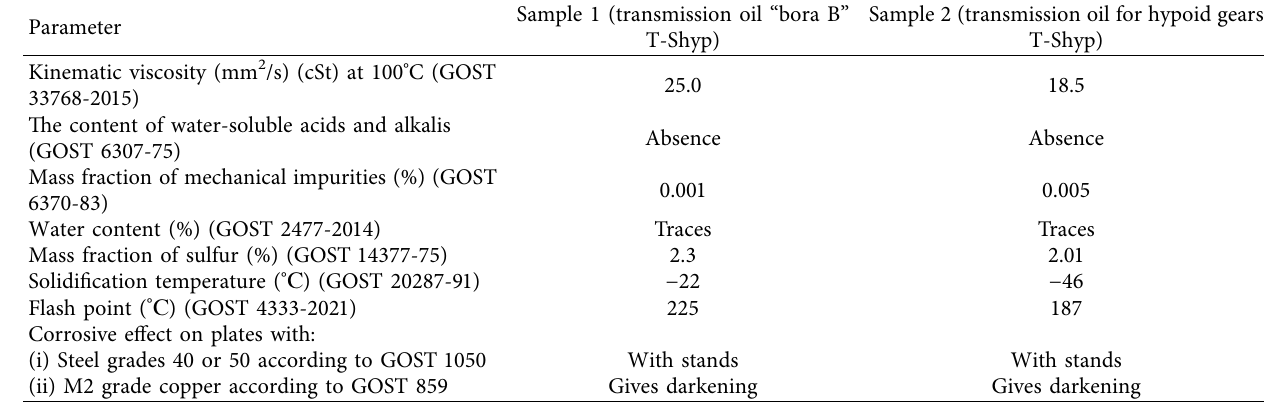
Table 1: Physicochemical indicators of transmission oil for hypoid gears T-Shyp.